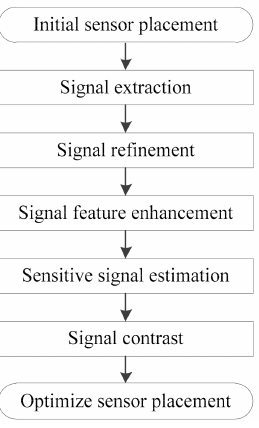
Figure 3. Flow chart of the data fusion